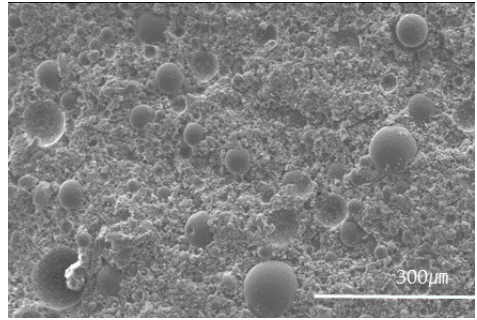
Figure 8. Scanning Electron Microscope (SEM) photograph of tensile specimen ‘green’ part.